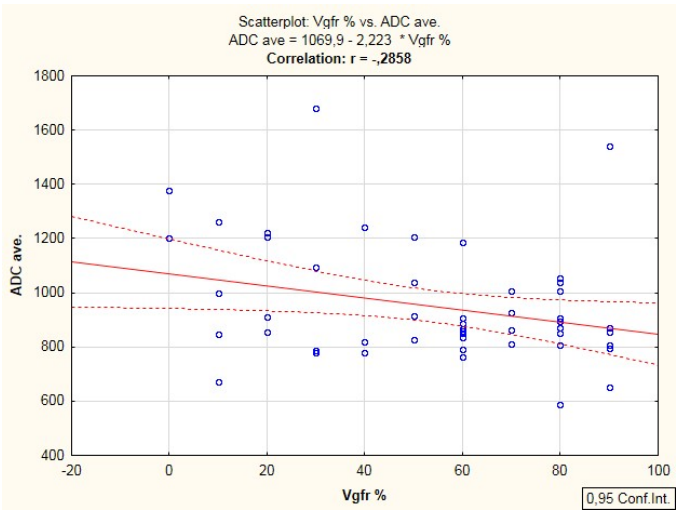
Figure 8. Correlation between VEGF expression and mean ADC ( p = 0.042).